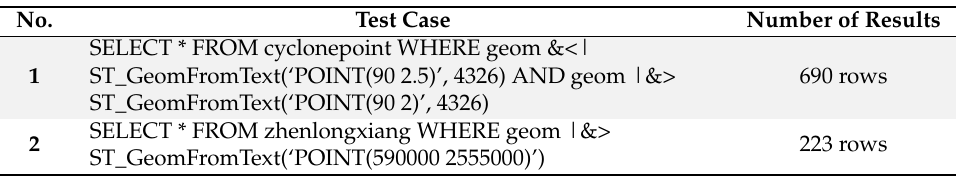
Table 14. Test cases of directional queries.